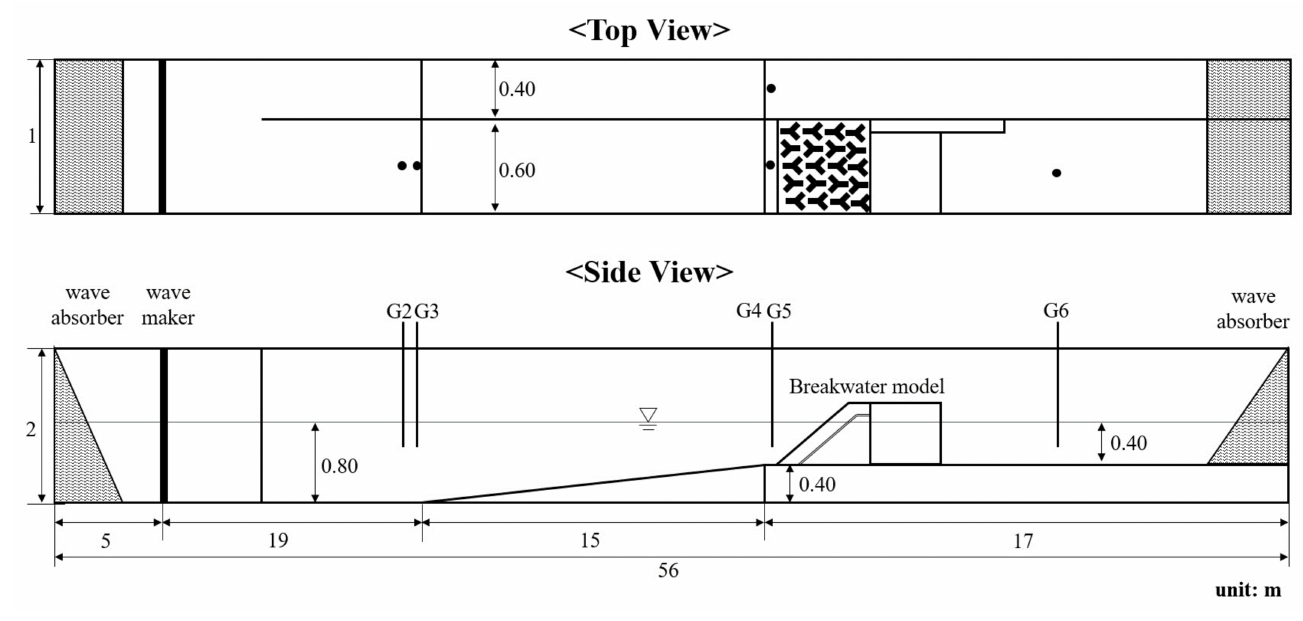
Figure 2. Dimensions of the wave